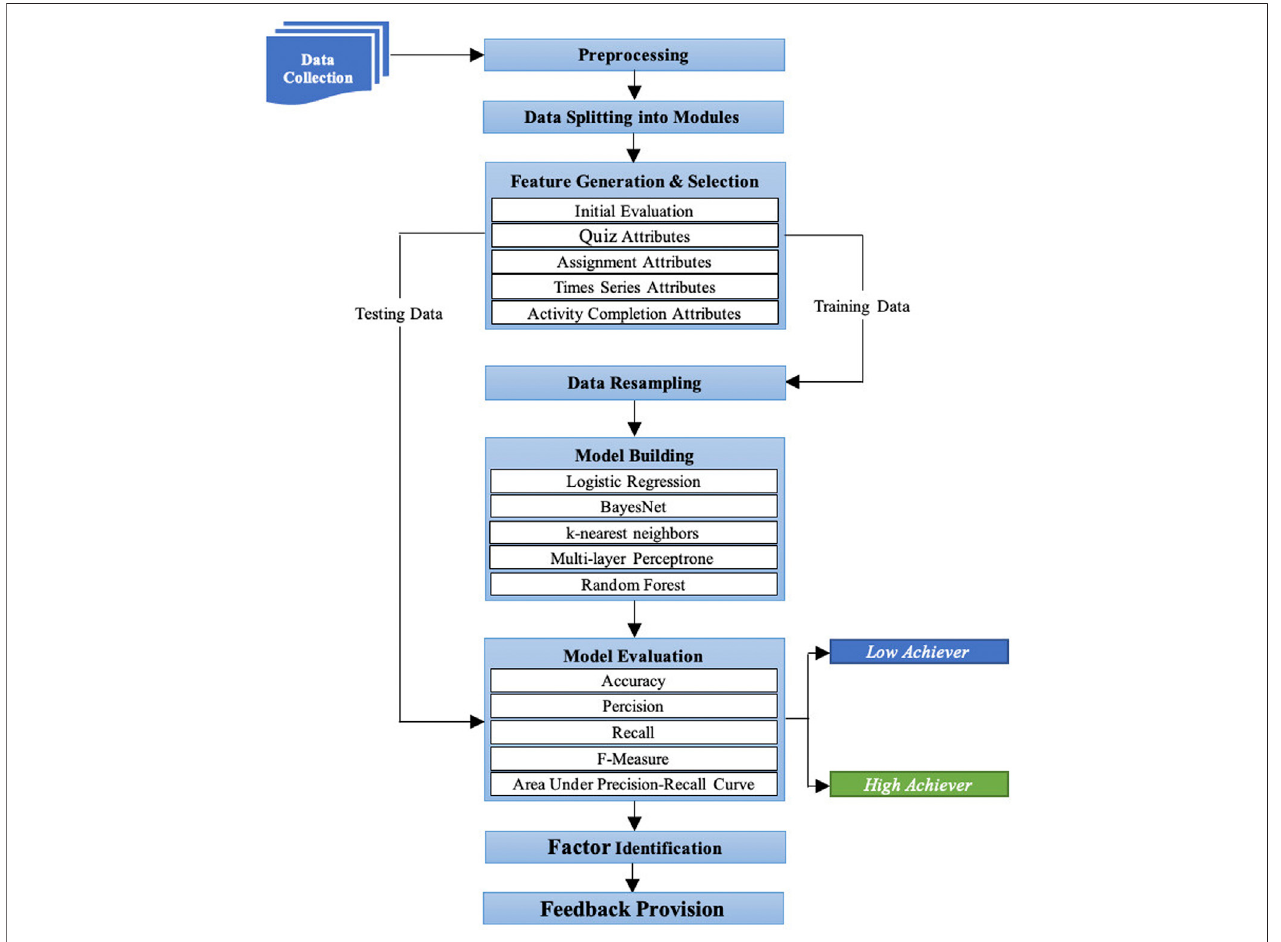
FIGURE 1 | An explainable machine learning-based approach to predict and explain student performance at the assignment level.